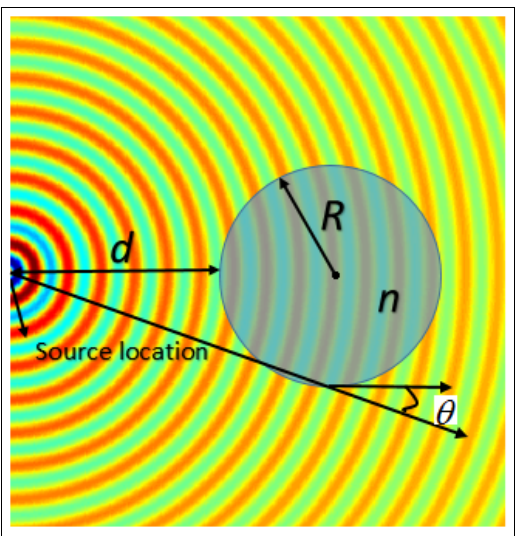
Figure 1. Schematic representation of the photonic structure illuminated by a point-source.